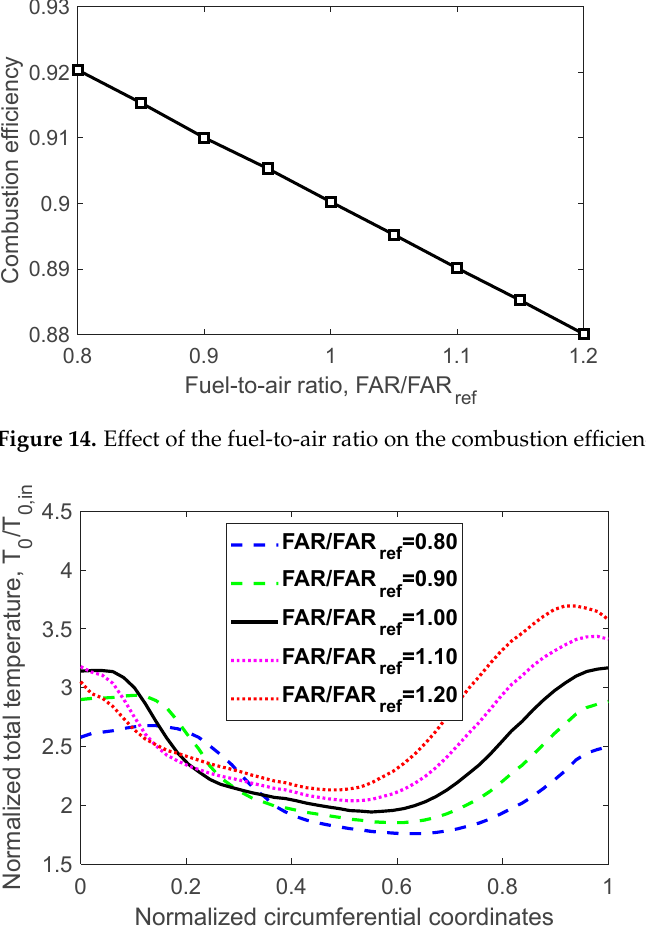
Figure 14. E ff ect of the fuel-to-air ratio on the combustion e ffi ciency.